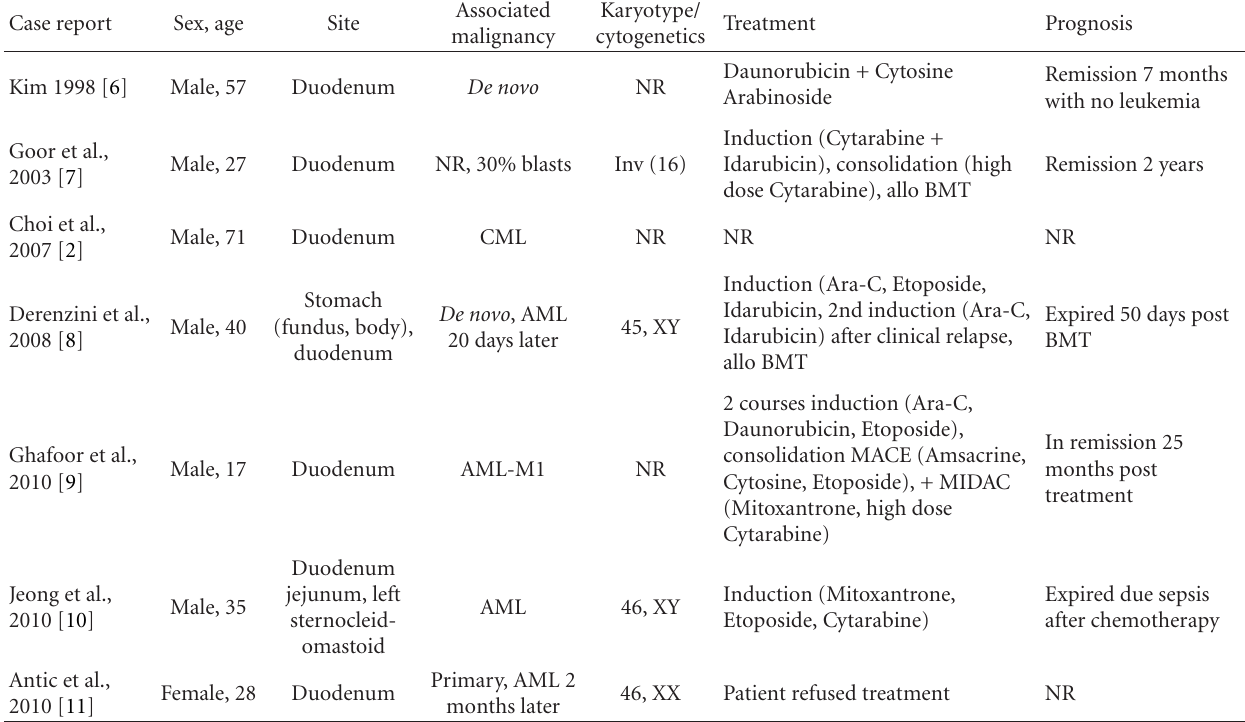
Table 1: Published reports of primary duodenal myeloid sarcomas